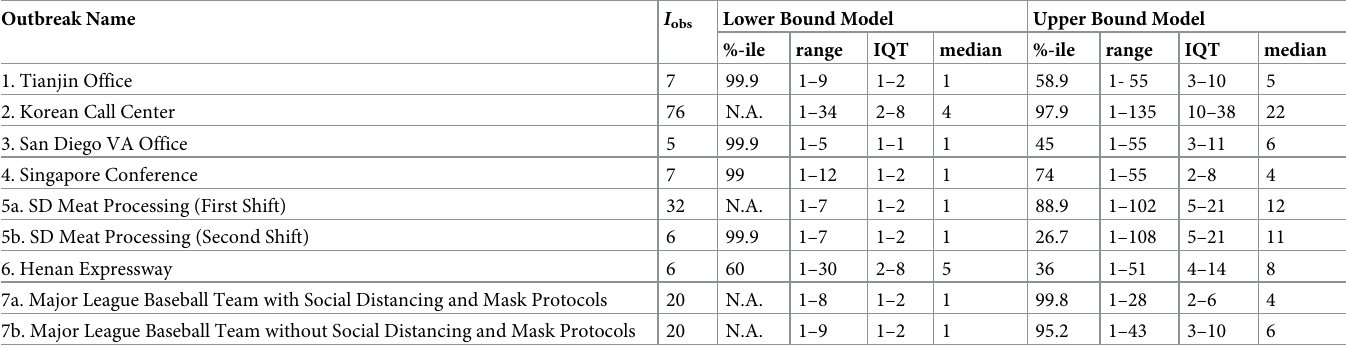
Table 2. Observations and model estimates for workplace outbreak reports.